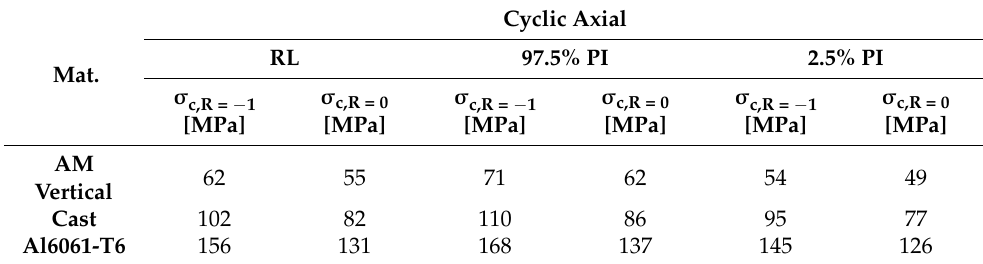
Table 5. Fatigue limit used in fatigue lifetime estimation.